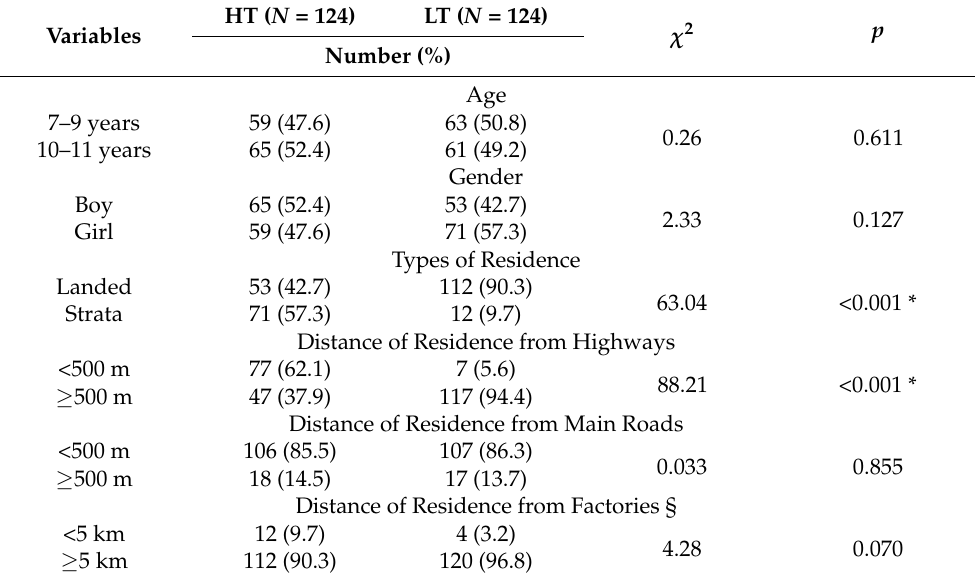
Table 1. Background of respondents.